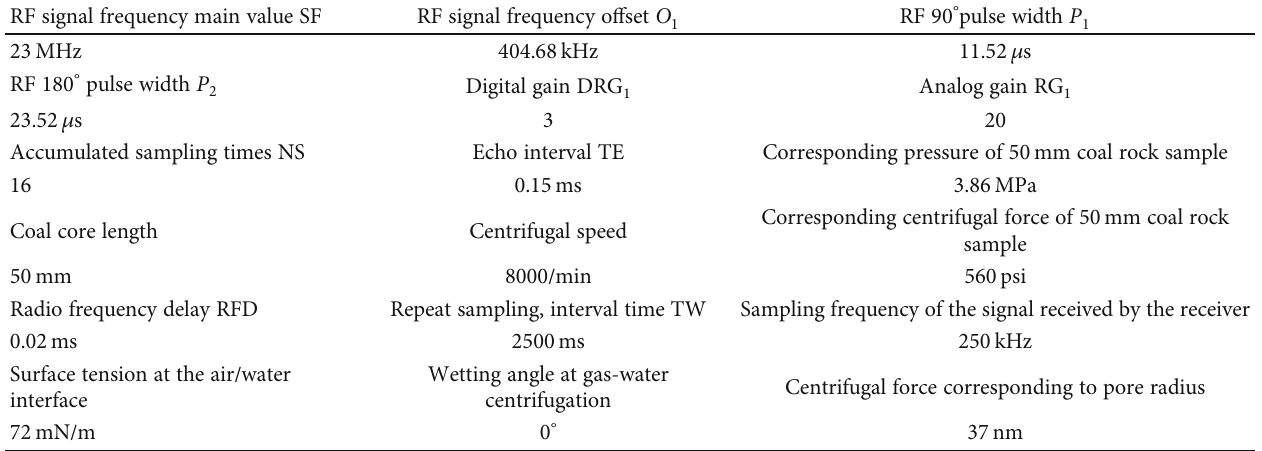
Table 1: NMR test parameter setting